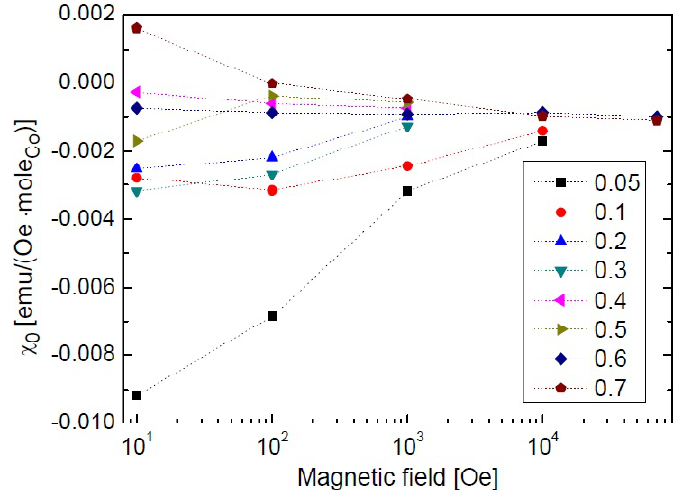
Fig. 4. Dependence of temperature-independent susceptibility  tigated samples.